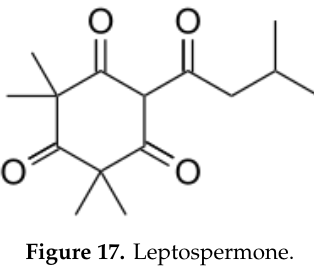
Figure 17. Leptospermone.